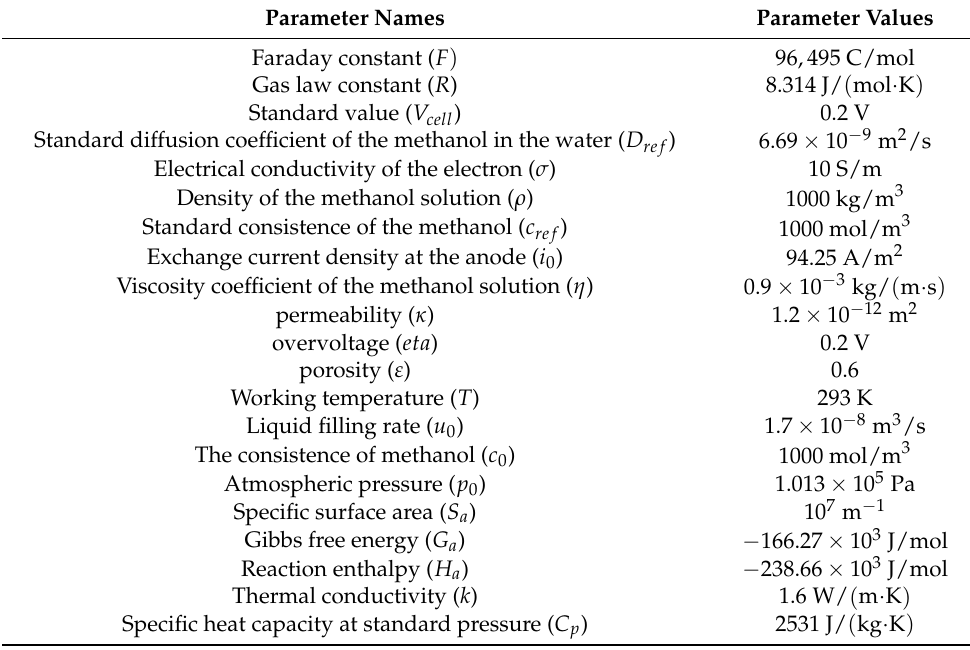
Table 4. Parameters used in the anode model